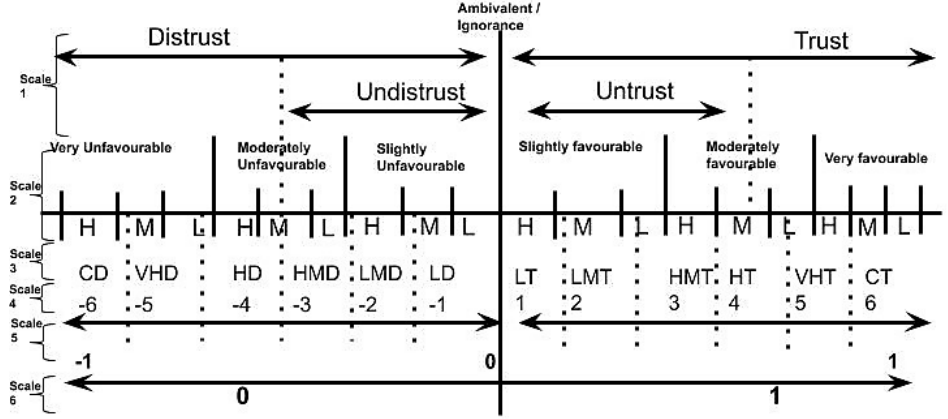
Figure 11. Comprehensive trust scale adopted from [20,55]: H = high, M = medium, L = low, CD = complete distrust, CT = complete trust, VHD = very high distrust, VHT = very high trust, HD = high distrust, HT = high trust, HMD = high medium distrust, HMT = high medium trust,